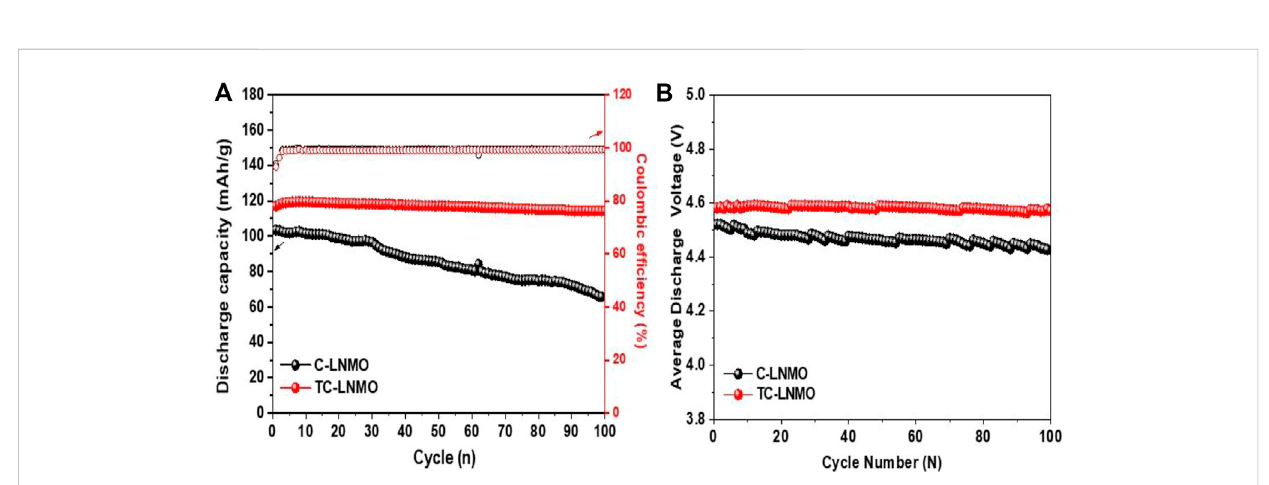
Cycling performances of C-LNMO and TC-LNMO samples. (A) Capacity and Coulombic ef fi ciency for 100 cycles at 1 ° C rate. (B) The average discharge voltage